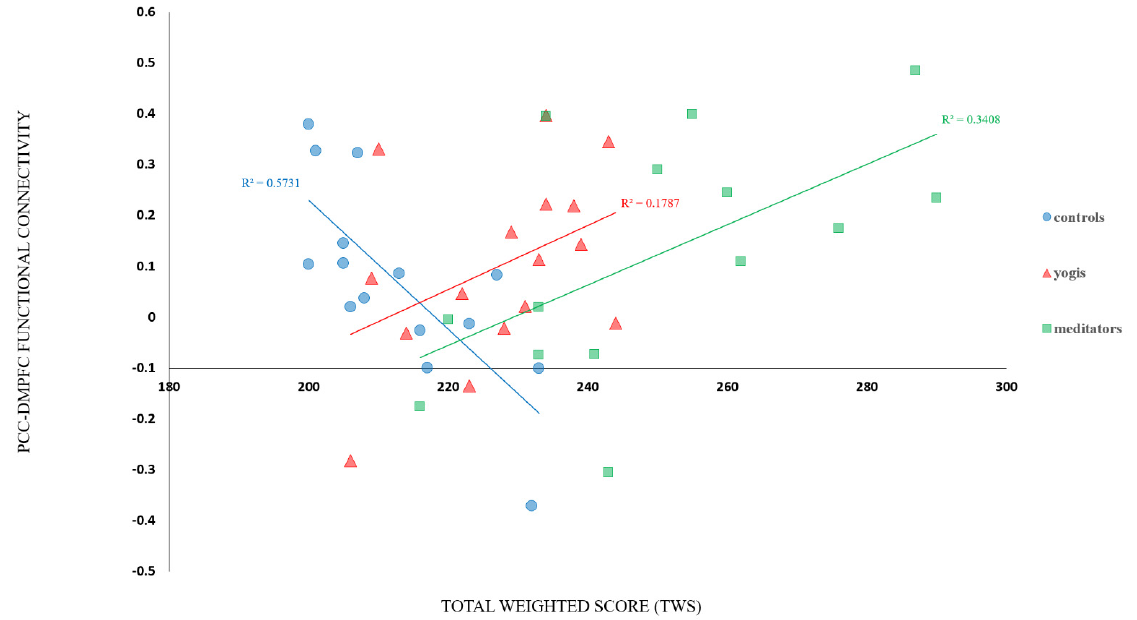
Figure 5. The correlation between TWS and PCC-dmPFC connectivity showing inflection points at the threshold between the Self-Conscious (3/4) and Conscientious (4) stages, indicated by a TWS of ≈ 220.